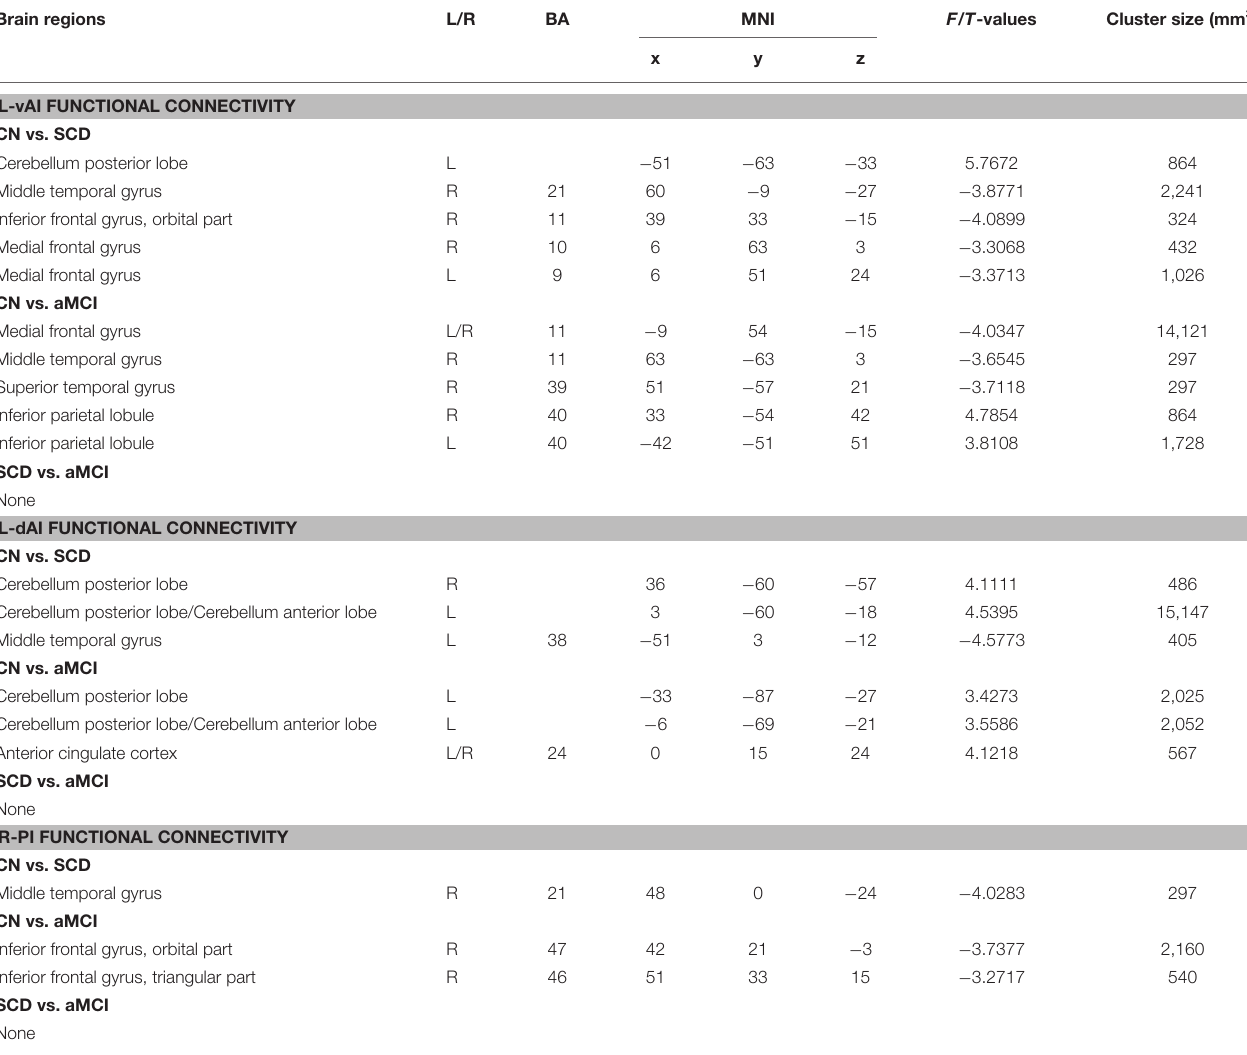
TABLE 2 | Comparisons of functional connectivity of insular subregions among aMCI, SCD, and CN subjects. Brain